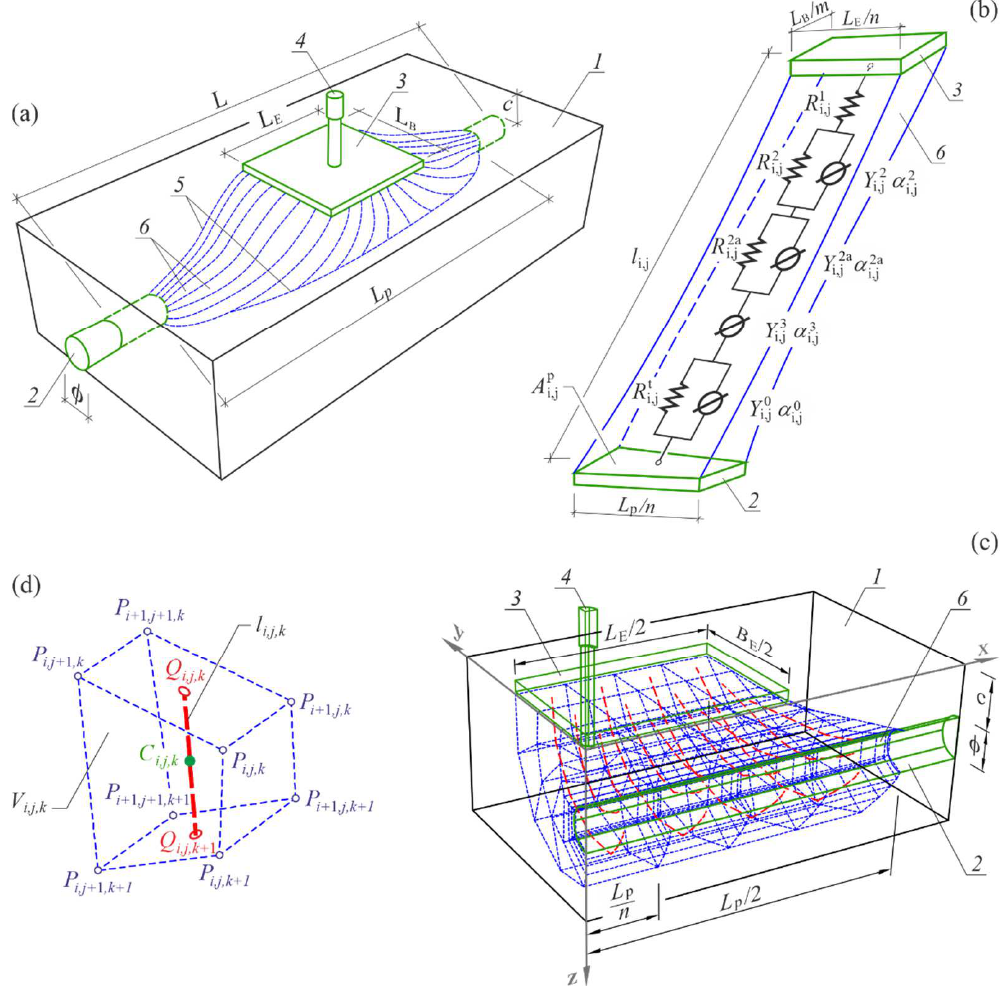
Figure 1. General arrangements for the 3D model of the steel-concrete system ( a ) view of the mod- elled system with concrete volume 5 that was electrically conductive during the EIS measurements.